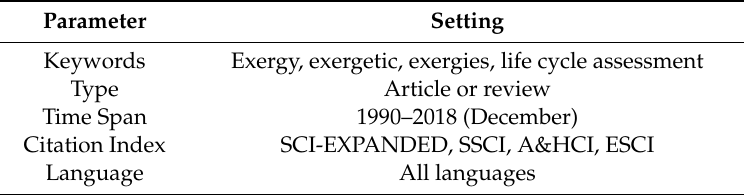
Table 3. Overview of input data for search of articles on exergy